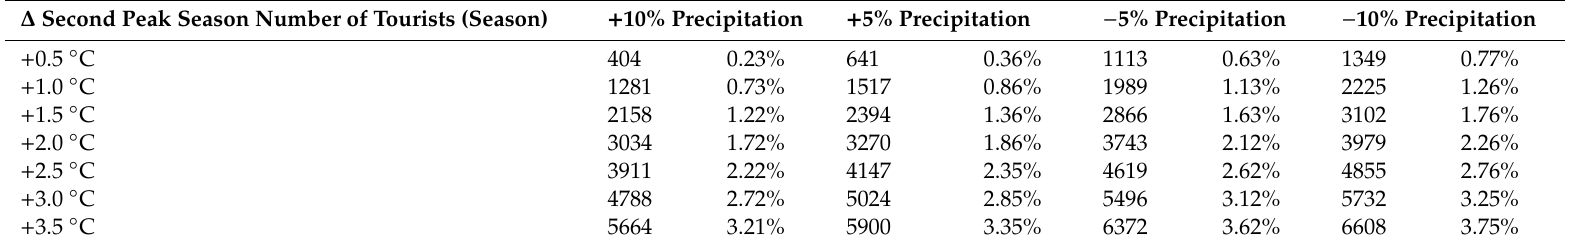
Table 7. Second peak season number of tourists increase (persons per season) and increate rate (%). ∆ Second Peak Season Number of Tourists (Season)